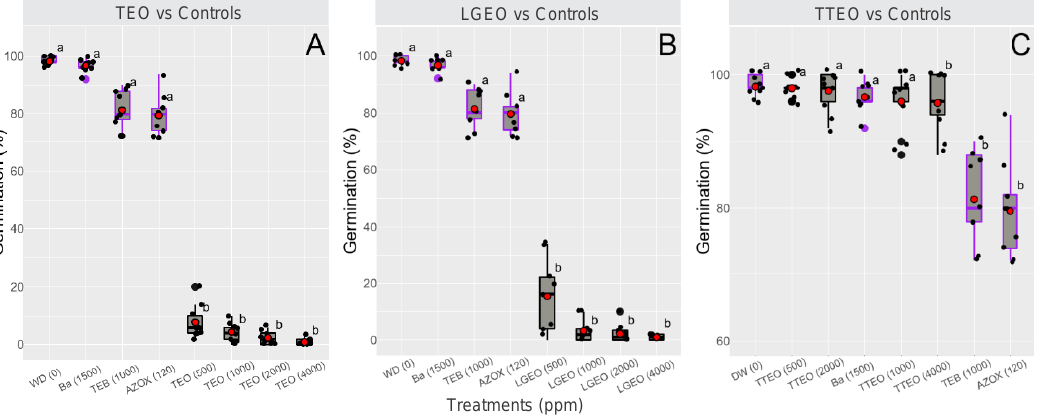
Figure 3. Effect of different essential oils (EOs) on the germination percentage of Alternaria linariae conidia. Treatments: essential oils of thyme (TEO; A ), lemongrass (LGEO; B ) and tea tree (TTEO; C ). Controls: Bacillus amyloliquefaciens MBI600 (Ba), tebuconazole (TEB), azoxystrobin (AZOX) and dis- tilled water (DW). Boxes with the same letters do not differ based on the Kruskal ‒ Wallis test (p ≤ 0.05) with p value adjustment according to the Dunn – Bonferroni test (p ≤ 0.05). Black and purple boxes represent common and control treatments, respectively. Bold points represent the distribution of values from three independent experiments (n = 9) and red points indicate the mean of treatments. 3.3. Antifungal Activity of Essential Oils Against the Fungal Isolate under In Vivo Conditions 3.3.1. Infected Leaf Area All tomato plants inoculated with A . linariae showed symptoms of tomato early blight (EB) at seven days after inoculation (DAI). However, the lowest percentage of infected leaf area was observed in plants treated with tebuconazole, BCA MBI600 and TEO at 6.99%, 12.70% and 20.07%, respectively, and was statistically lower (p ≤ 0.05) than that for water-treated plants, which exhibited a 37.71% infected leaf area (Figure 4).